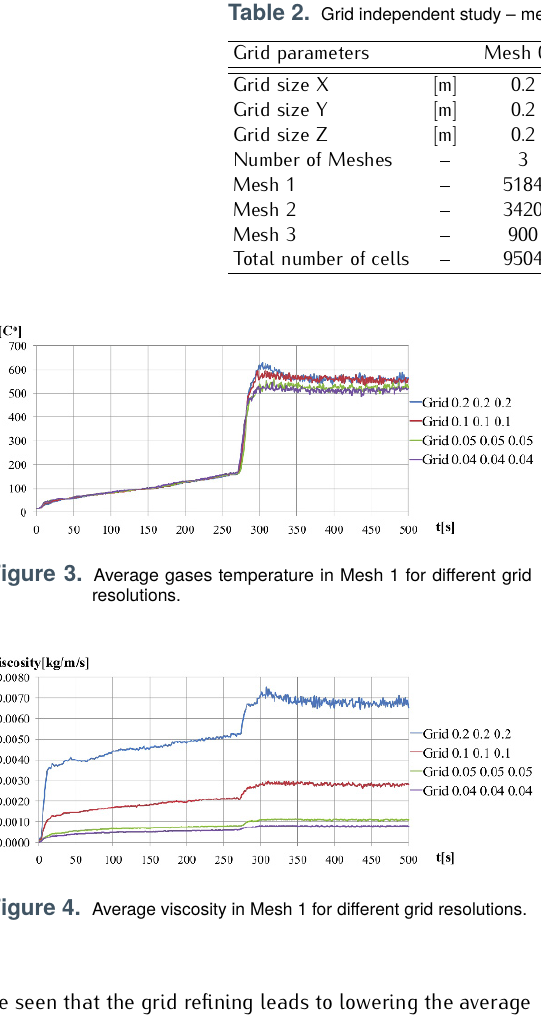
be seen that the grid refining leads to lowering the average gas temperature in the TC. For the temperature analysis the grid independent solutions can be selected at 0.05 m resolution, as it does not differ significantly from 0.04 m resolution. Fig. 4 shows average viscosity for the different resolutions. 0.2, 0.1 and 0.05, 0.04 grids. The grid size of 0.05 can